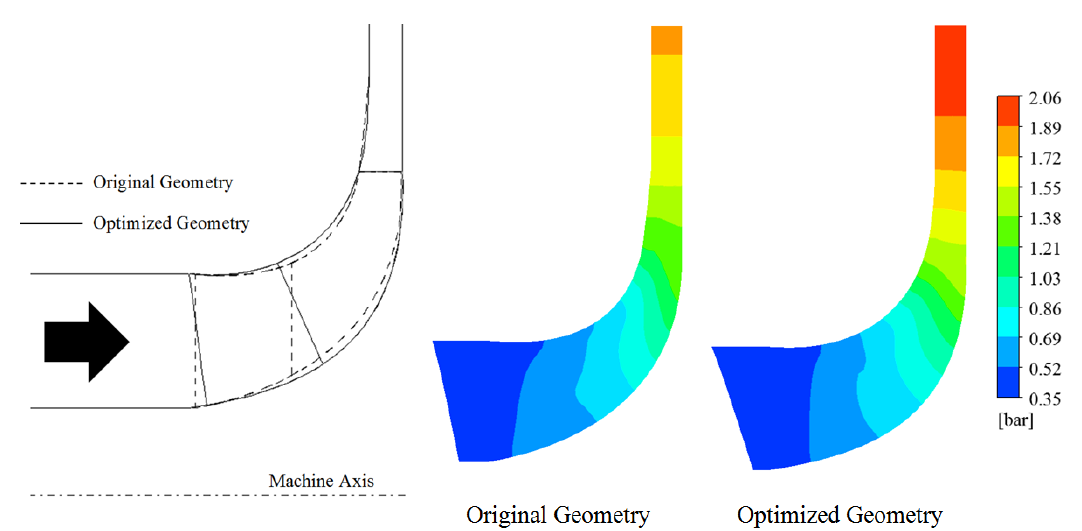
Figure 20. Optimized and original cases meridional view and the pressure contours comparison at design